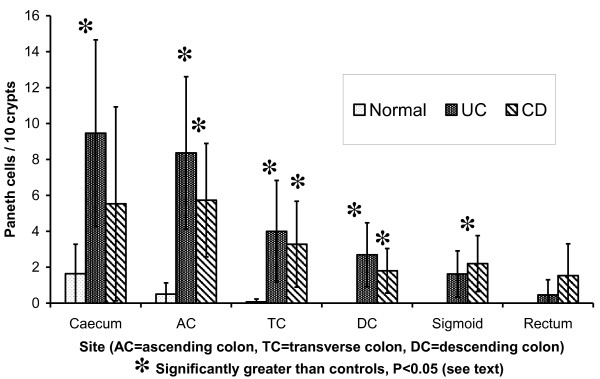
Numbers of Paneth cells (mean and 95% confidence interval) by site.